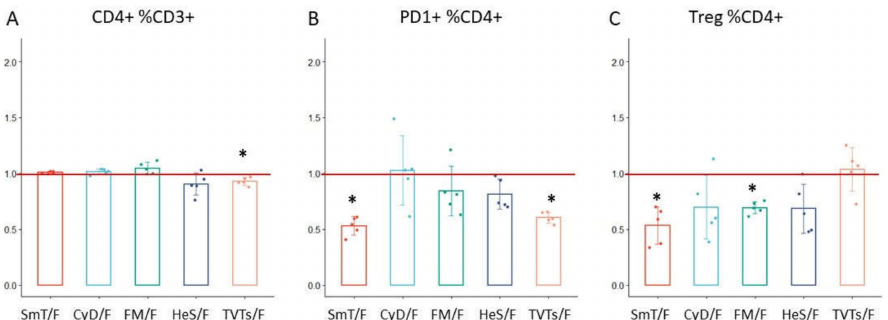
Figure 5. Comparison of CD4 T-cell subsets using the five cryopreservation methods. The cell frequency variation in thawed (T) with respect to fresh (F) sample (represented as T/F ratio) is shown for each cryopreservation method. The red line indicates the ideal ratio of 1 (i.e., with no cell frequency variation between cryopreserved and fresh whole blood). The variation of ( A ) CD4 T cells, ( B ) PD1+ CD4 T cells, and ( C ) Tregs were represented as mean values of 5 samples ± standard deviation. * p -values from the paired t -test < 0.05.